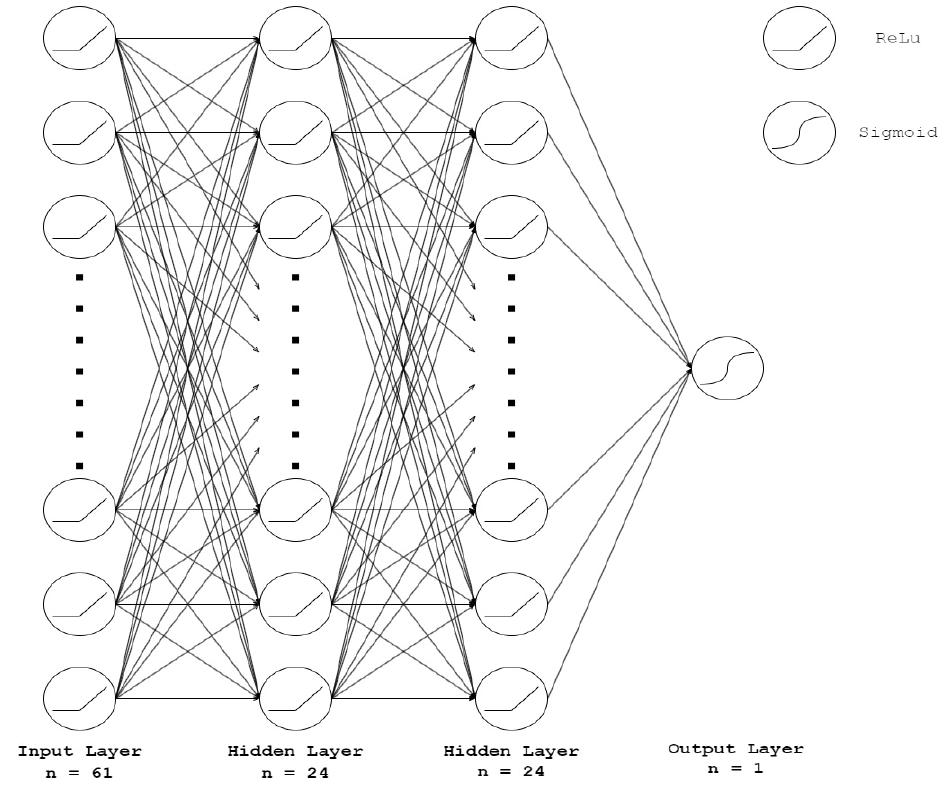
Figure 2. An example of the structure of the DNN we constructed.